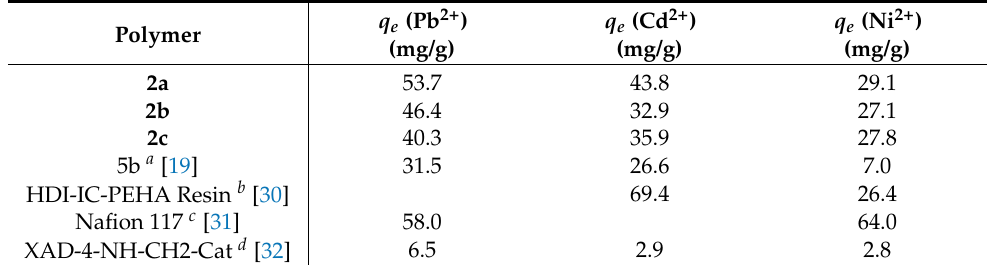
Table 4. Maximum amounts of adsorption of Pb 2+ , Cd 2+ and Ni 2+ by the thiol-functionalized polymers studied in this work and other previously published adsorbent